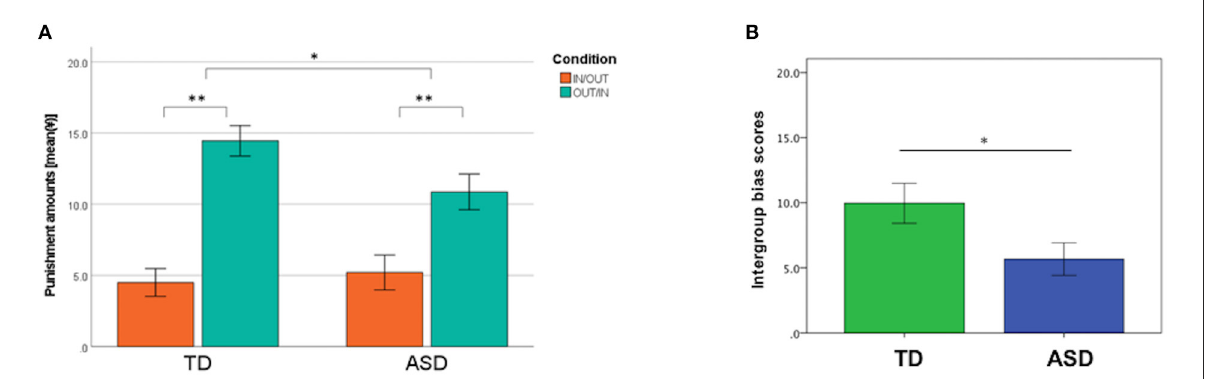
FIGURE2 Behavioral data in the third-party punishment task. (A) The mean amounts of punishment in the IN/OUT (the proposer was an ingroup member, whereas the recipient was an outgroup member) and OUT/IN (the proposer was an outgroup member, whereas the recipient was an ingroup member) conditions in the typical development (TD) and autism spectrum disorder (ASD) groups. The 2 × 2 mixed analysis of variance revealed the presence of a group × condition interaction effect ( F = 4.65, p = 0.036). (B) Intergroup bias scores in the TD and ASD groups. * p < 0.05, ** p < 0.01. These p -values were not corrected for multiple testing. Error bars indicate ± standard errors.